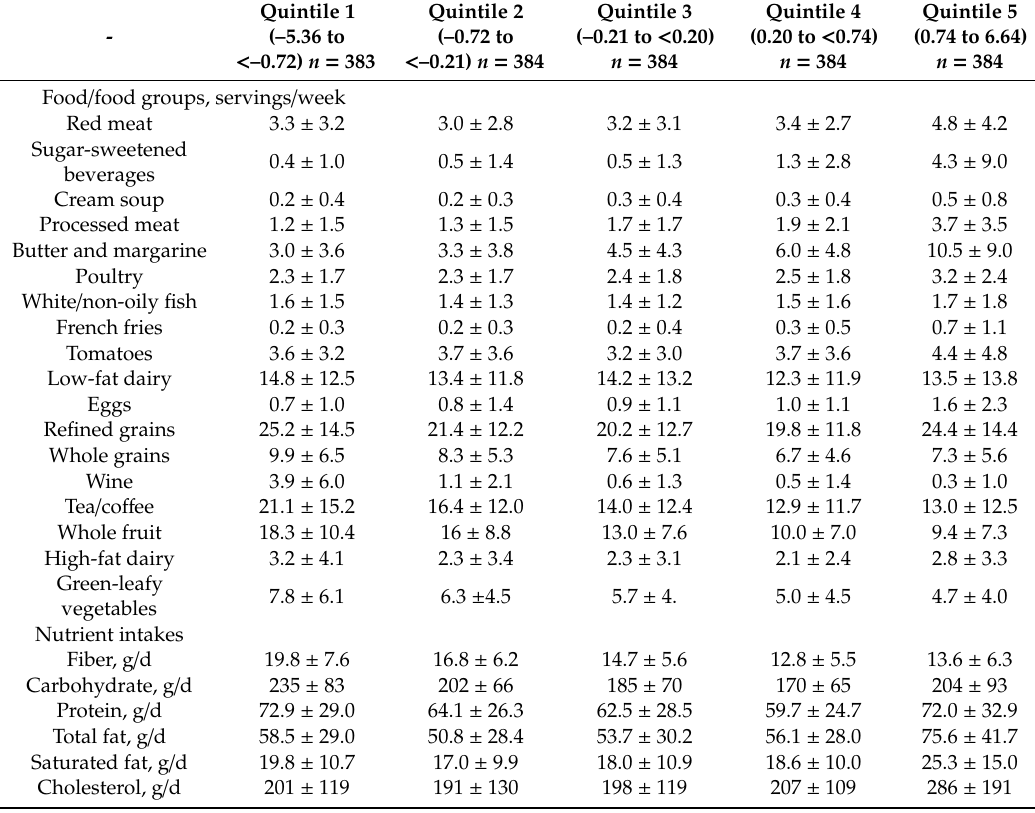
Table 3. Distribution of dietary intakes across quintiles of the EDIH score (metabolomics study samples—combined discovery and replication datasets) 1,2,3